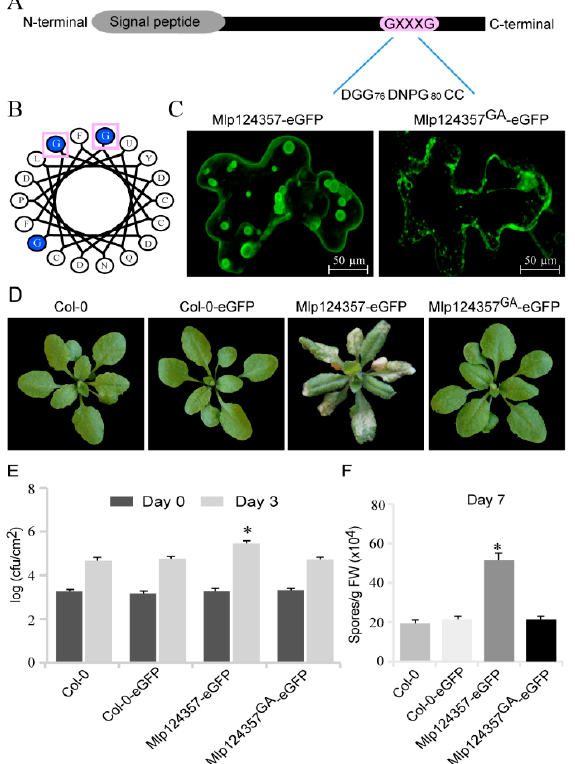
Figure 3. Mlp124357 possesses a GxxxG motif that is required for the interaction with tonoplasts. ( A ) Schematic representation of the GxxxG motif in the C-terminus region of Mlp124357. ( B ) A predicted helical wheel projection of Mlp124357. The glycine residues at positions 76 and 80 are indicated by square boxes. ( C ) Fluorescence imaging of N. benthamiana cells expressing eGFP fusions of Mlp124357 and Mlp124357 GA mutant at 2 dpi using confocal microscopy of epidermal cells. ( D ) Morphology of each genotype. Photographs are from 4-week-old soil-grown plants. ( E ) Leaves of each genotype were infiltrated with a PstDC3000 bacterial suspension at OD 600 = 0.001 and bacterial growth was quantified in colony-forming units (cfu) on day 0 and day 3 after infection. One-way ANOVA ( p < 0.05) with Tukey’s test was performed. The asterisk indicates a statistically significant di ff erence between Col-0-eGFP, Mlp124357-eGFP, and Mlp124357GA-eGFP. Five replicates were used for each genotype. ( F ) Each genotype was spray inoculated with H. arabidopsidis Noco2 spores (20,000 conidiospores / mL) and the number of conidiospores was quantified 7 days after inoculation. Statistical significance was evaluated using one-way ANOVA with Tukey’s test (significance set at p < 0.05). The asterisk denotes a significant di ff erence between Col-0-eGFP, Mlp124357-eGFP, and Mlp124357GA-eGFP. FW, fresh weight. Both bacterial and oomycete infection experiments were repeated at least three times and representative data are